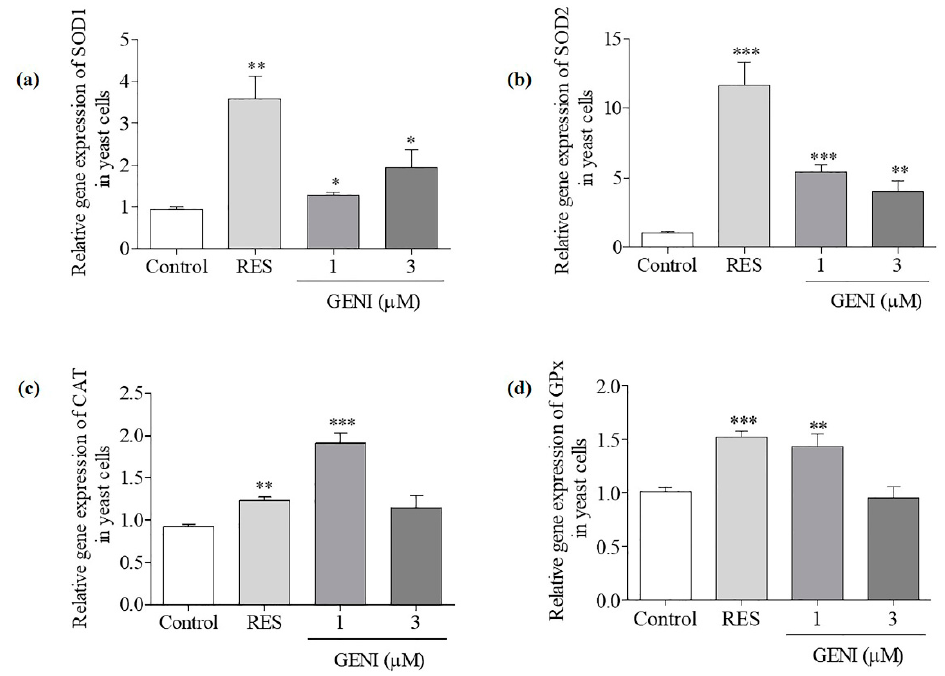
Figure 4. Effect of GENI on SOD1 ( a ), SOD2 ( b ), CAT ( c ) and GPx ( d ) gene expression in BY4741 yeast after treatment of GENI and RES (10 µM). Experiments were repeated thrice, and the data are presented as means ± SEM. * p < 0.05, ** p < 0.01, and *** p < 0.001 represent significant difference compared with the control group.